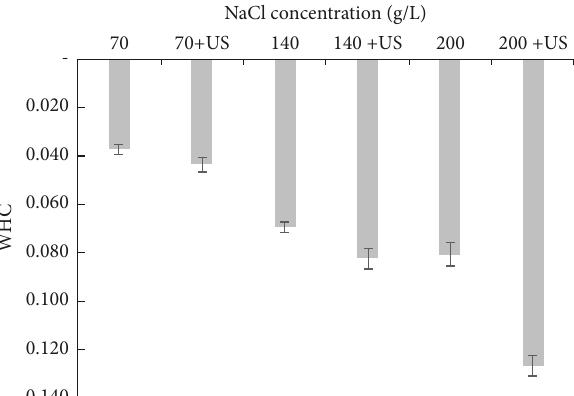
Figure4:EffectoftreatmentsonWaterHoldingCapacity(WHC)of rabbitmeataftermarinatingassistedbypowerultrasoundorinstatic bath at different salt concentrations (70, 140, and 200 g